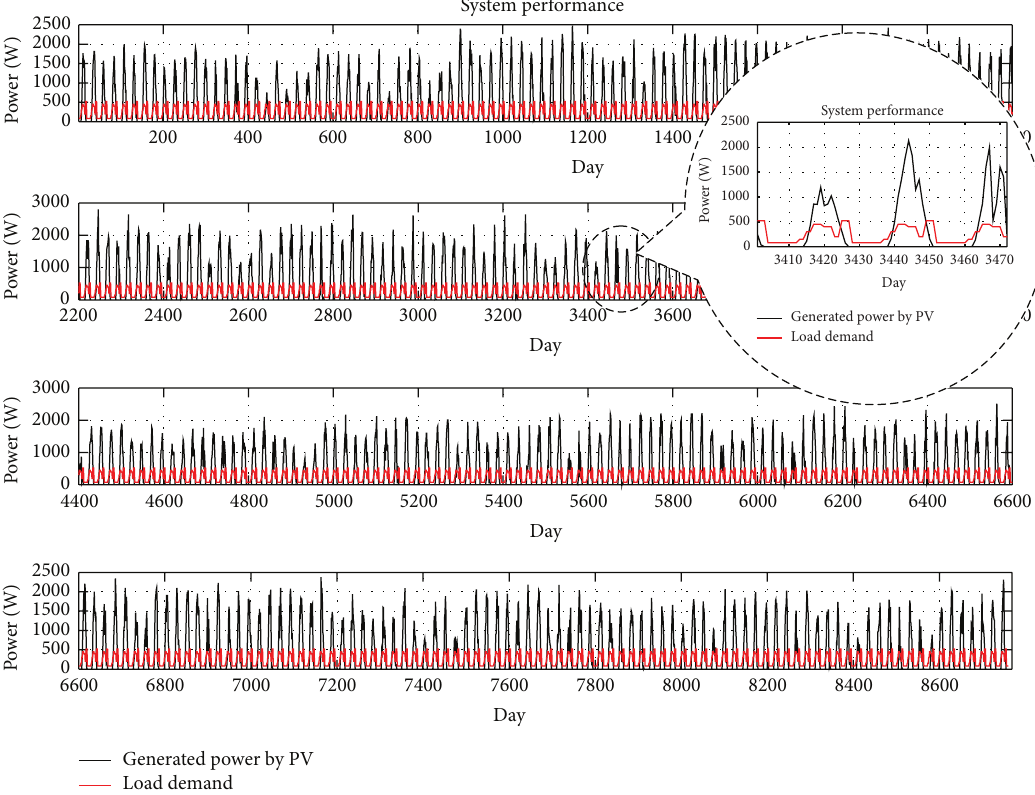
Figure 5: Generated power by the designed